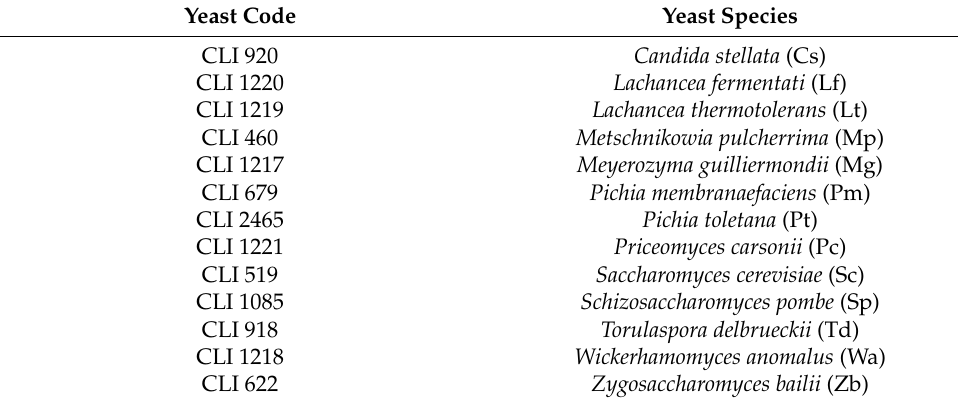
Table 1. Yeast strains tested in this study isolated from spontaneous fermentations of grape variety Malvar. Yeast abbreviation included in